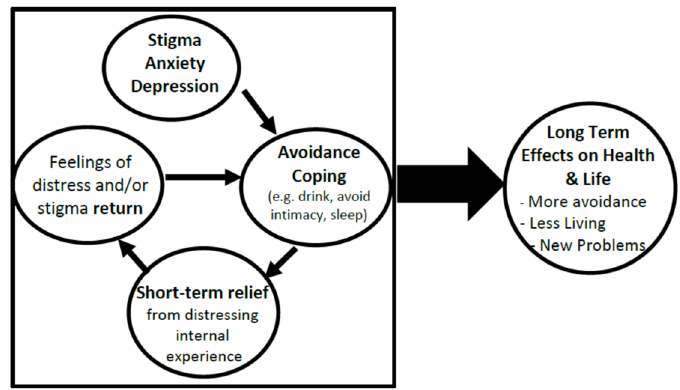
Figure 1. Long term effects of avoidance coping.